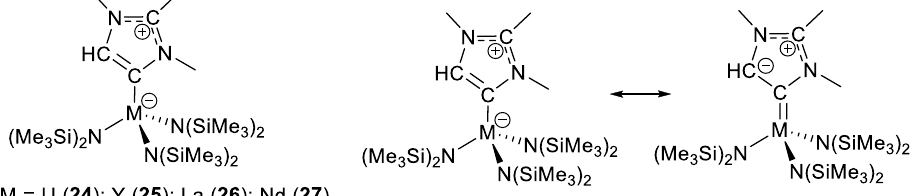
Figure 7. U and Ln – mesoionic carbene (MIC) complexes and two of the principal resonance forms for the MIC complexes.